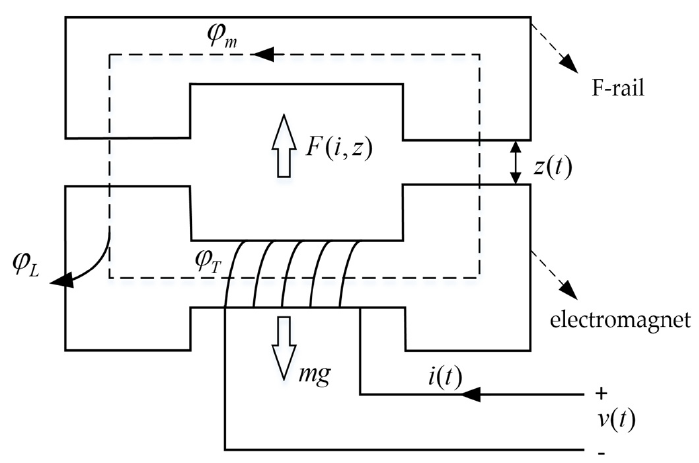
Table 1. Main parameters of suspension system.